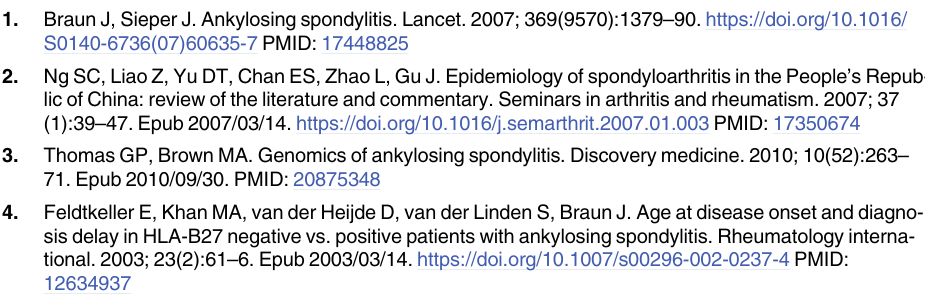
S5 Table. The genotype frequencies of identified SNPs in dominant genetic models in AS cases and controls. S6 Table. Results of the analyses in different genetic models in males. S7 Table. BASDAI and BASFI scores in AS patients with different